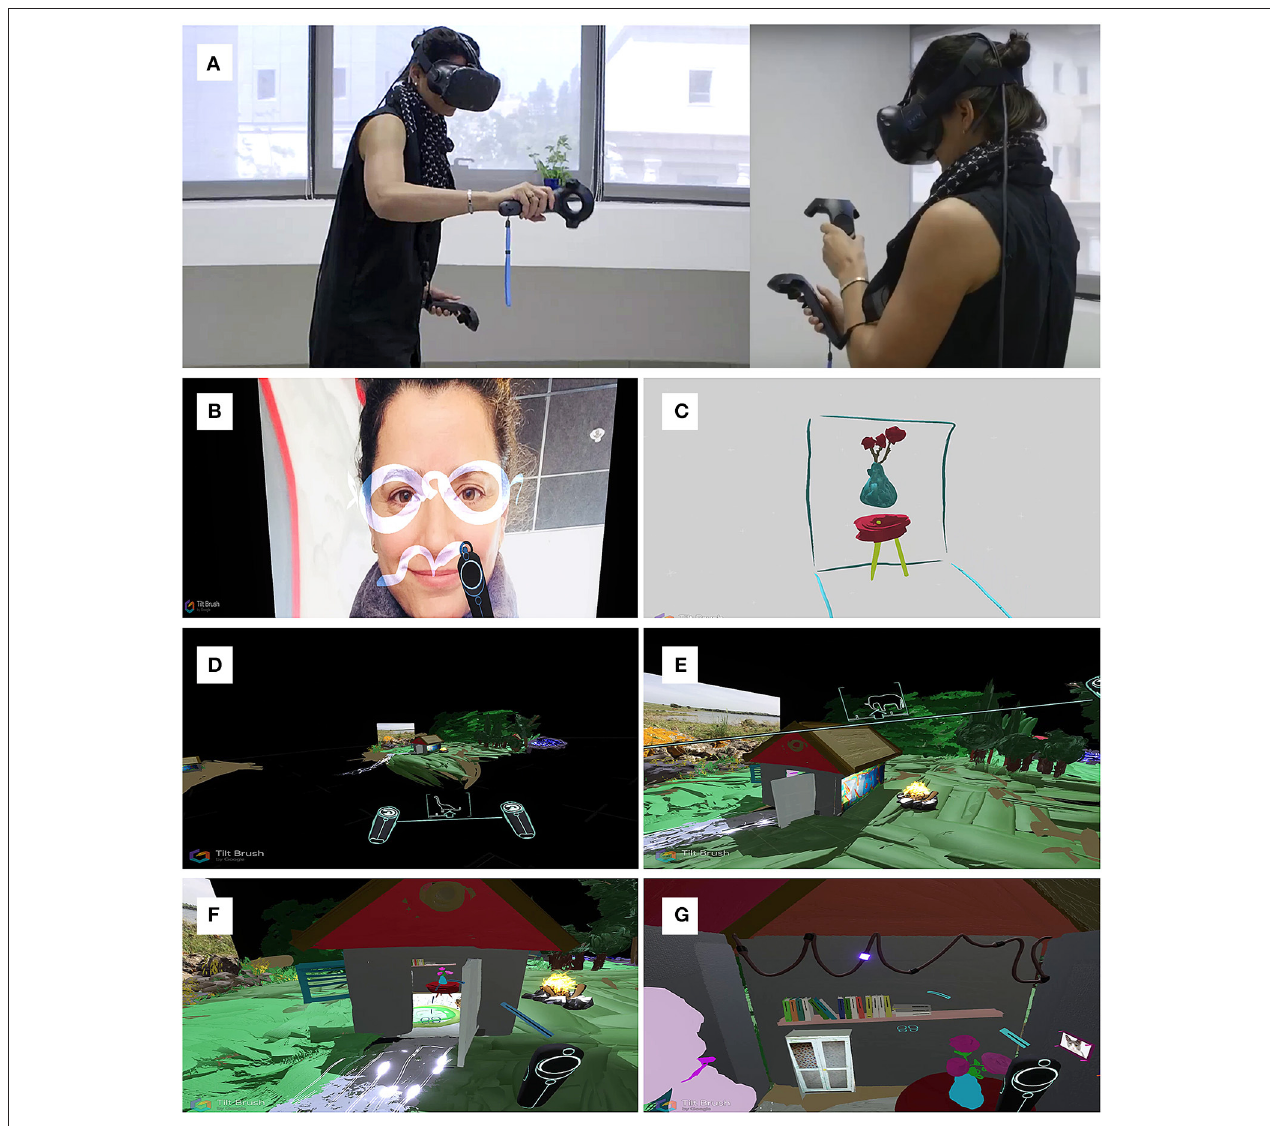
FIGURE 1 | Artistic creation in VR. (A) The virtual reality setup. The creator wears an HMD and creates via the hand-held controllers, see also Supplementary Videos . (B) Photographic stimuli from the real world can be introduced as backgrounds or objects in VR, allowing interactions between real and virtual worlds. (C) Creation in VR includes unreal characteristics such as absence of gravity in a 3D environment. (D,E) The VR environment allows dynamic rescaling of the virtual world. The creator can modify the size of the artistic creation (and by proxy their relative size) at will. (F,G) As the virtual creation is a scalable 3D environment, the creator can “step into” his creations, enhancing the immersivity, and scope of the artistic